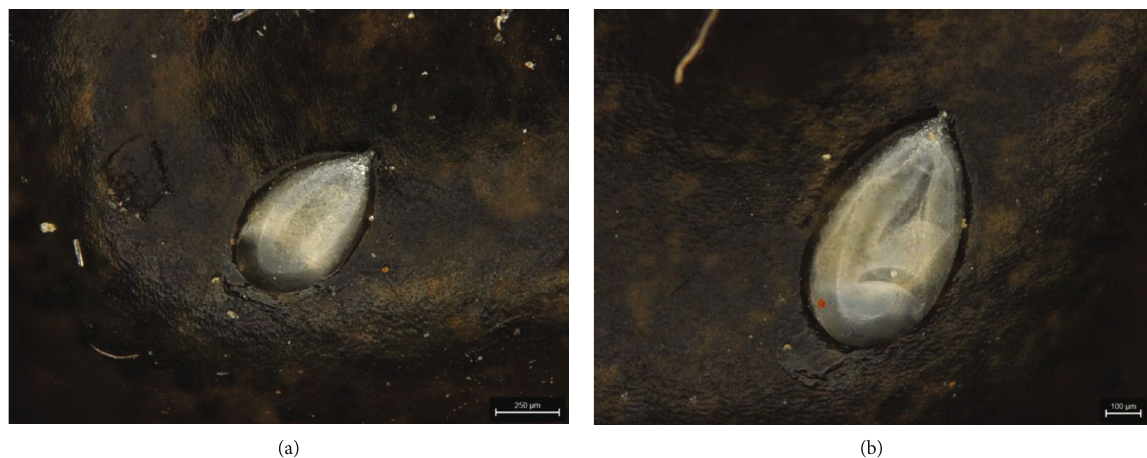
Figure 8: Microscopic image of eggs of Callosobruchus maculatus (a) before CO